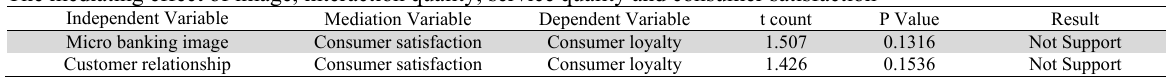
The mediating effect of image, interaction quality, service quality and consumer